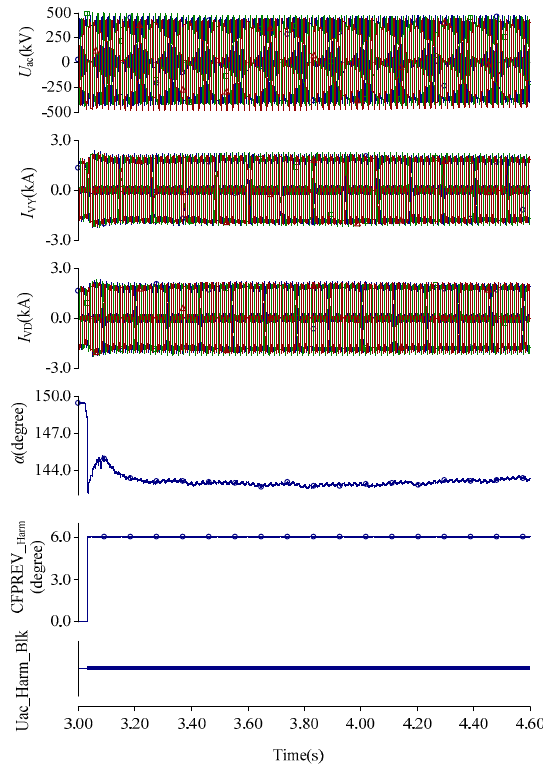
Figure 17. The test waveform when the improved commutation failure prediction algorithm is applied. (Note: I VD is the Yd transformer current in the valve side; CFPREV_ Harm is the output of CFPREV based on harmonic detection, Uac_Harm_Blk is the action signal of CFPREV based on harmonic detection.).